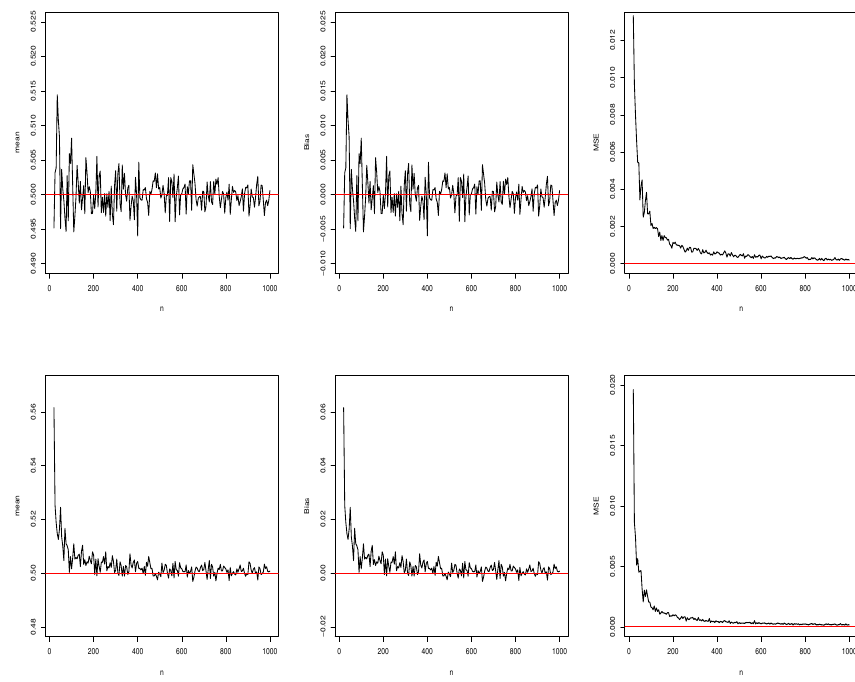
Figure 4. The results of the α ( top ) and β ( bottom ) parameters for the simulation-I.